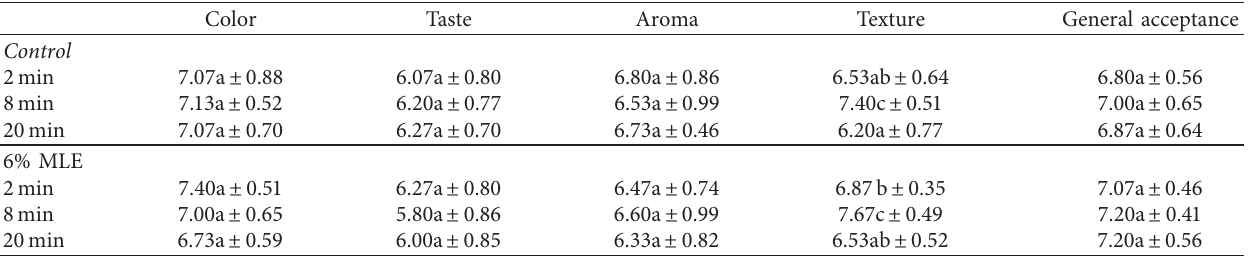
Table 1: Sensory evaluation scores of chocolate alginate beads (control and 6% w/w MLE) prepared with different hardening times. Color Taste Aroma Texture General